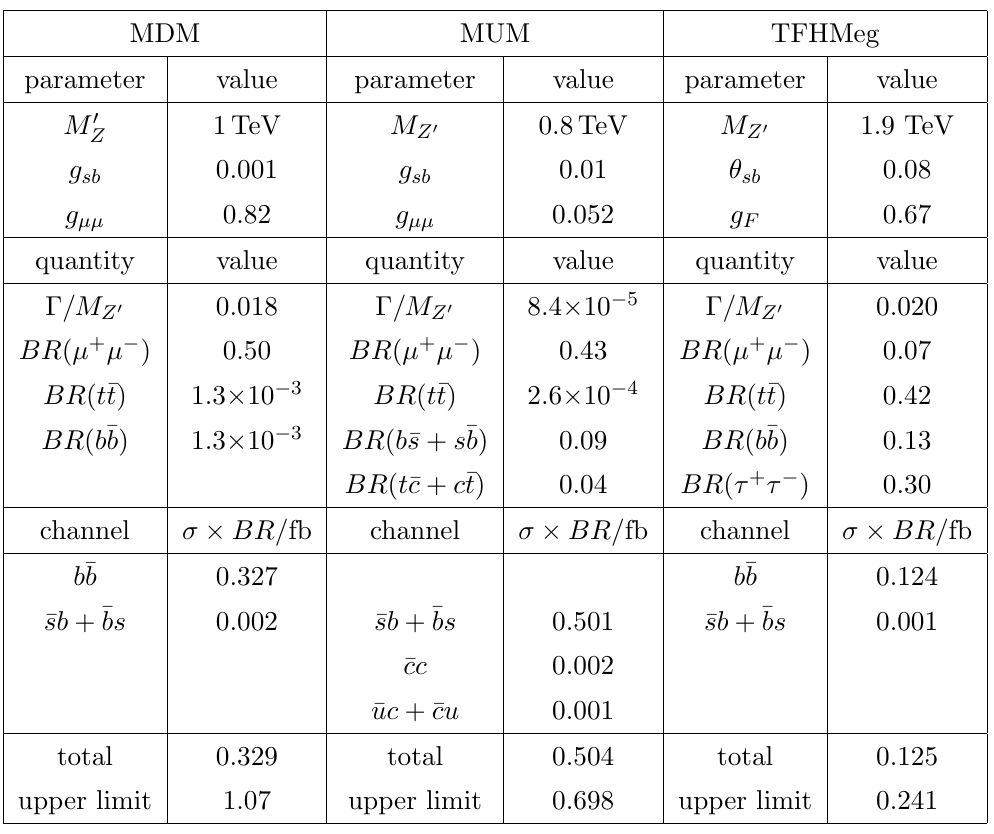
Table 1 . Illustration of example points in parameter space. The third parameter listed in each case is derived in terms of the two above it by the best (cid:12)t to the NCBAs, i.e. eq. (2.2) with x = 1 : 06. ‘channel’ lists the contribution to the total Z 0 cross-section times branching ratio from the various quark parton distribution functions (PDFs). For each production mode, we list the Z 0 (cid:12)ducial production cross-section times branching ratio into muon pairs (cid:27) (cid:2) BR . Other production modes have cross-sections that are smaller than 10 (cid:0) 3 fb. The upper limit on the cross-section is the